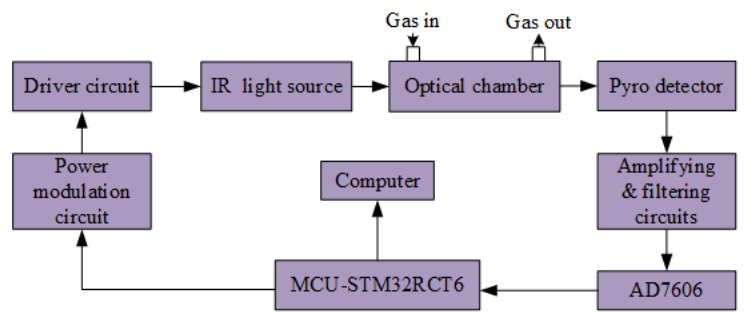
Figure 2. Hardware schematic of the NDIR detector used for multi-gas detection.